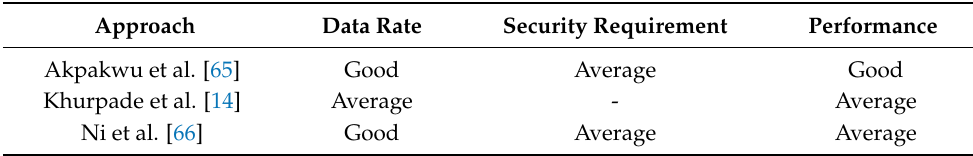
Table 8. Summary of IoT-based approaches in 5G